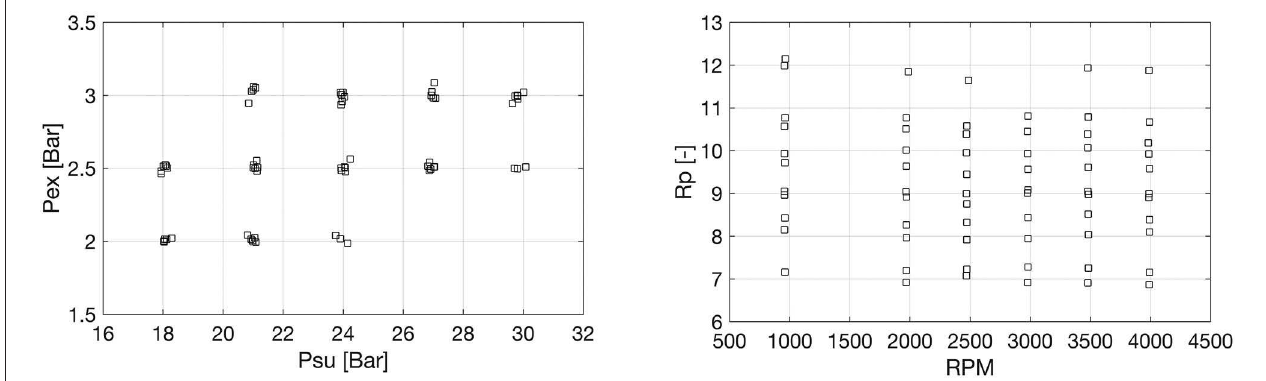
FIGURE 3 | Map of operating conditions achieved during the experimental campaign.